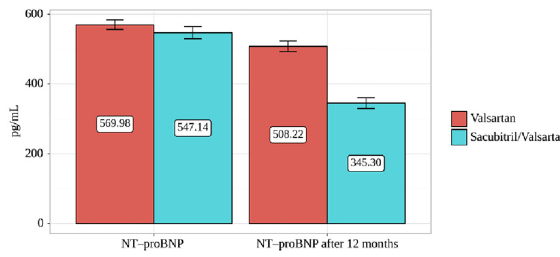
Figure 1. Changes in dynamics depending on treatment method. Data are reported as means and SD. Signi fi cant differences were found between groups at baseline (P o 0.05) and at the 12-month follow-up (P o 0.001) (Student ’ s t -test) and within groups at the two time-points (P o 0.001) (paired Student ’ s t -test).